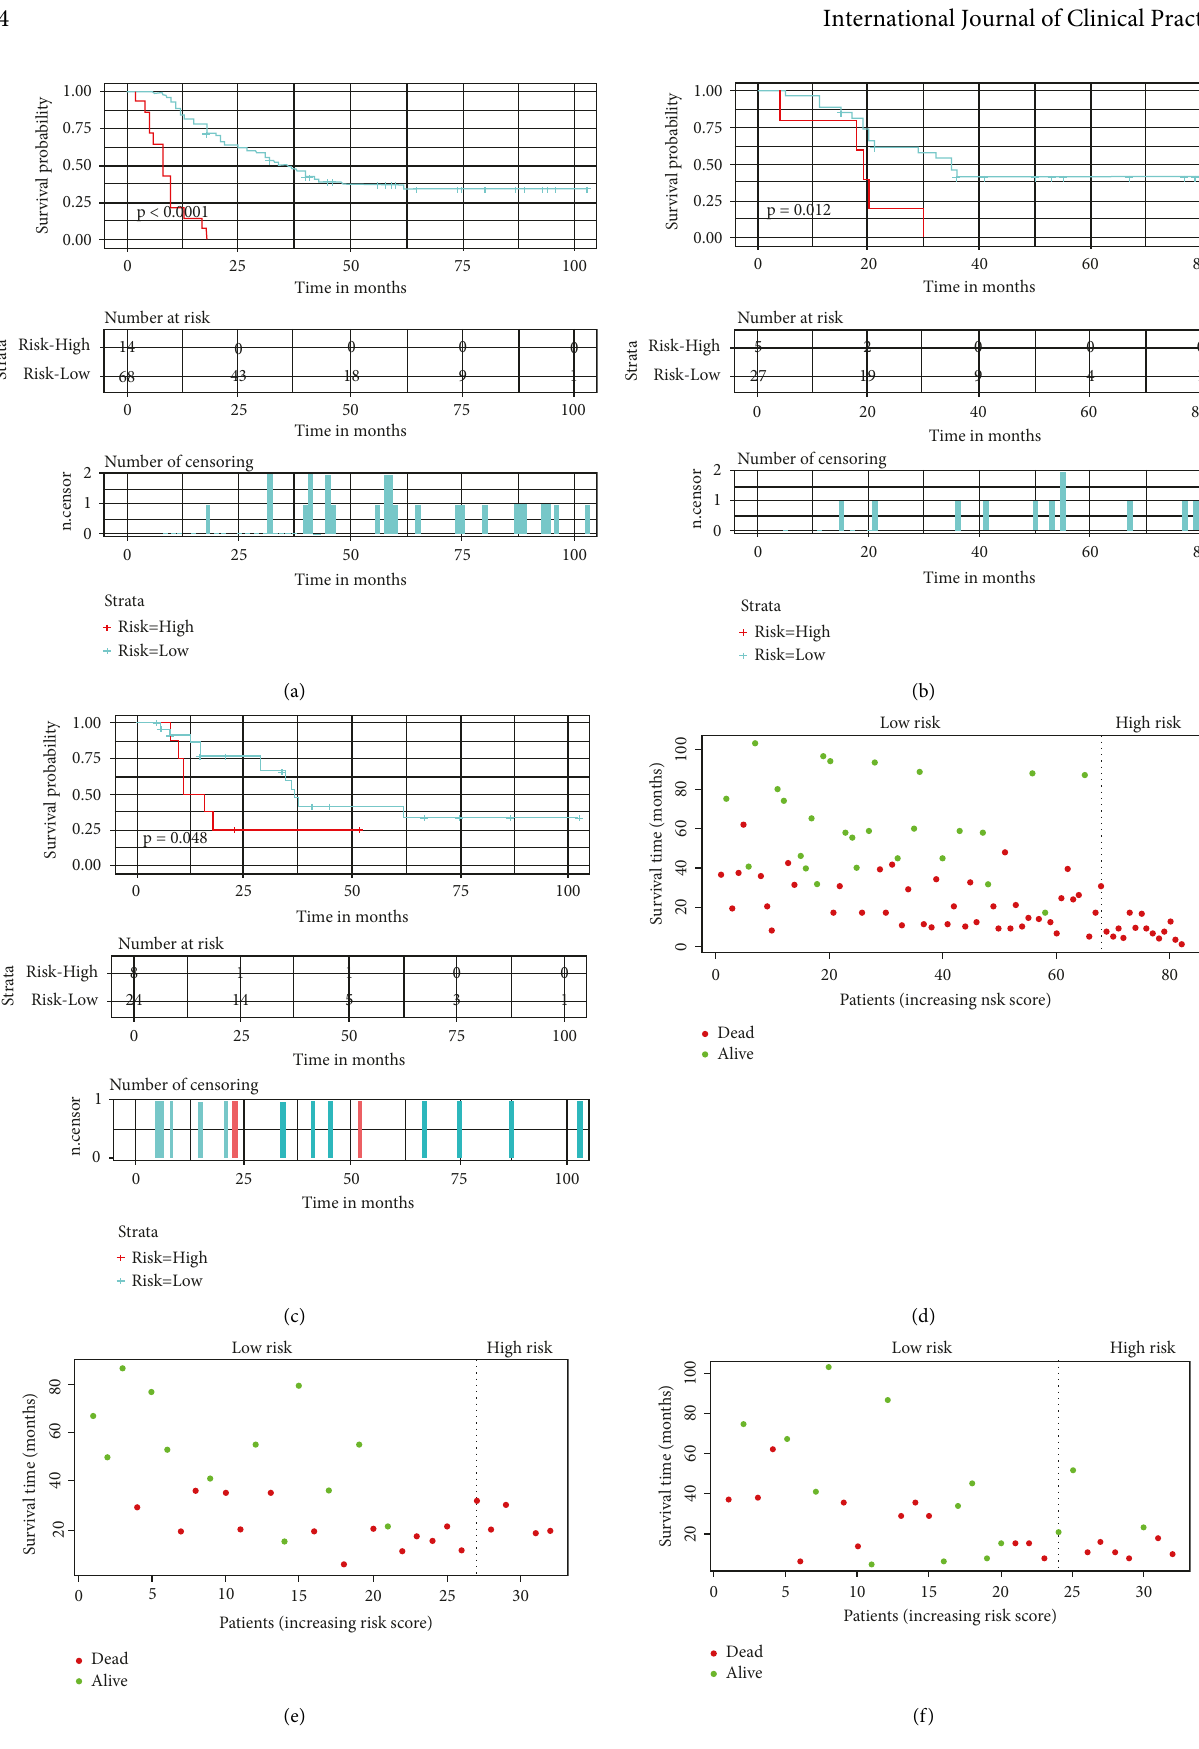
Figure 8: Risk stratification for young osteosarcoma patients with LM. The survival curve of two risk groups in the training set (a), internal validation set (b), and external validation set (c); a scatter diagram to show the survival status of patients in the training set (d), internal validation set (e), and external validation set